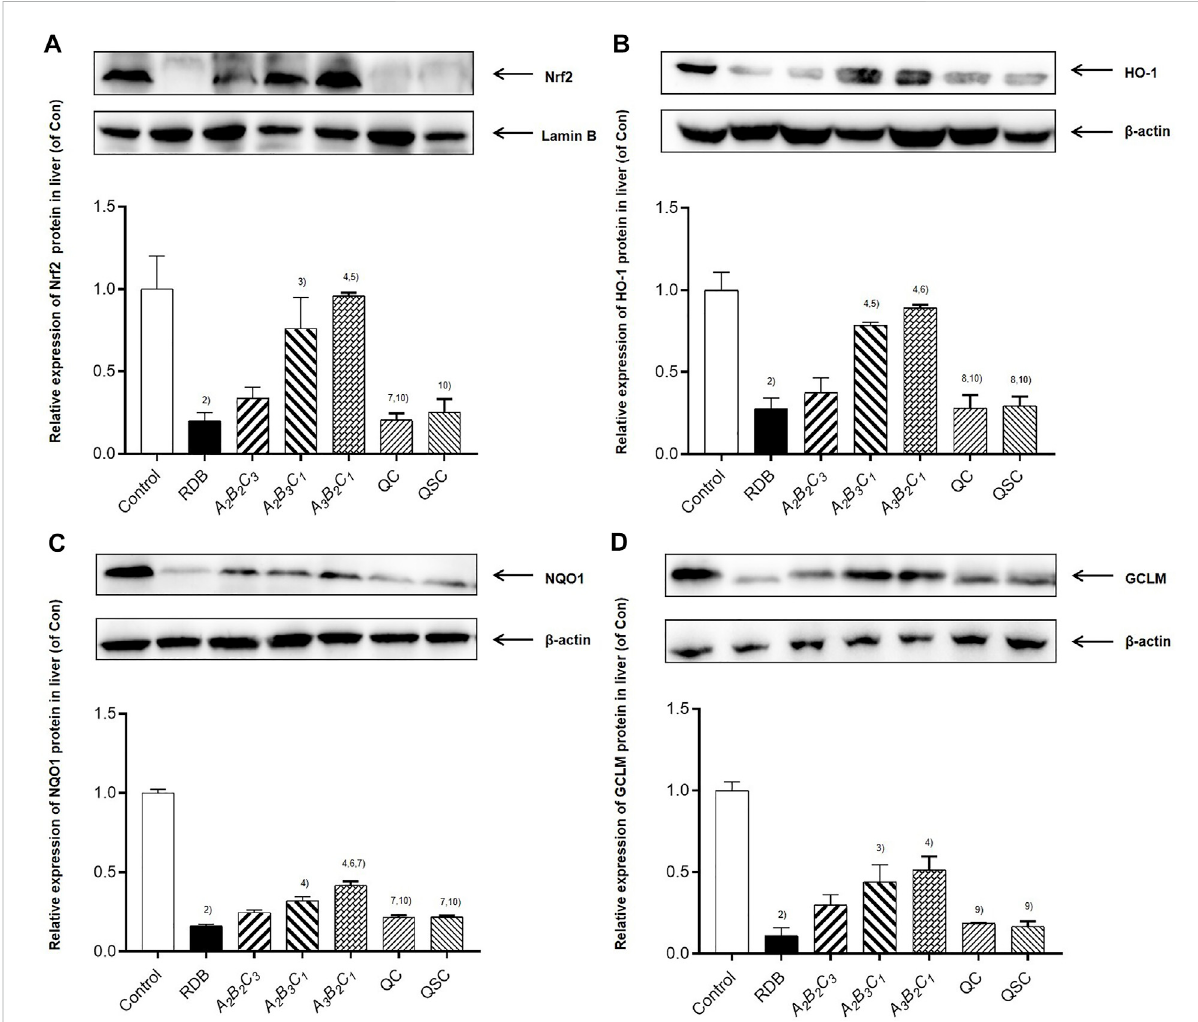
FIGURE 4 Processing with ASR reversed Nrf2-mediated antioxidant defense induced by RDB in mice. (A) Nrf2, (B) HO-1, (C) NQO1, (D) GCLM protein levels in liver determined by western blot. Data were expressed as mean ± S.E.M., with three mice in each group. 1) p < 0.05, 2) p < 0.01, compared withtheControlgroup,3) p < 0.05,4) p < 0.01,comparedwiththeRDBgroup,5) p < 0.05,6) p < 0.01,comparedwiththe A 2 B 2 C 3 group,7) p < 0.05,8) p < 0.01, compared with the A 2 B 3 C 1 group, 9) p < 0.05, 10) p < 0.01, compared with the A 3 B 2 C 1 group, 11) p < 0.05, 12) p < 0.01, compared with the QC